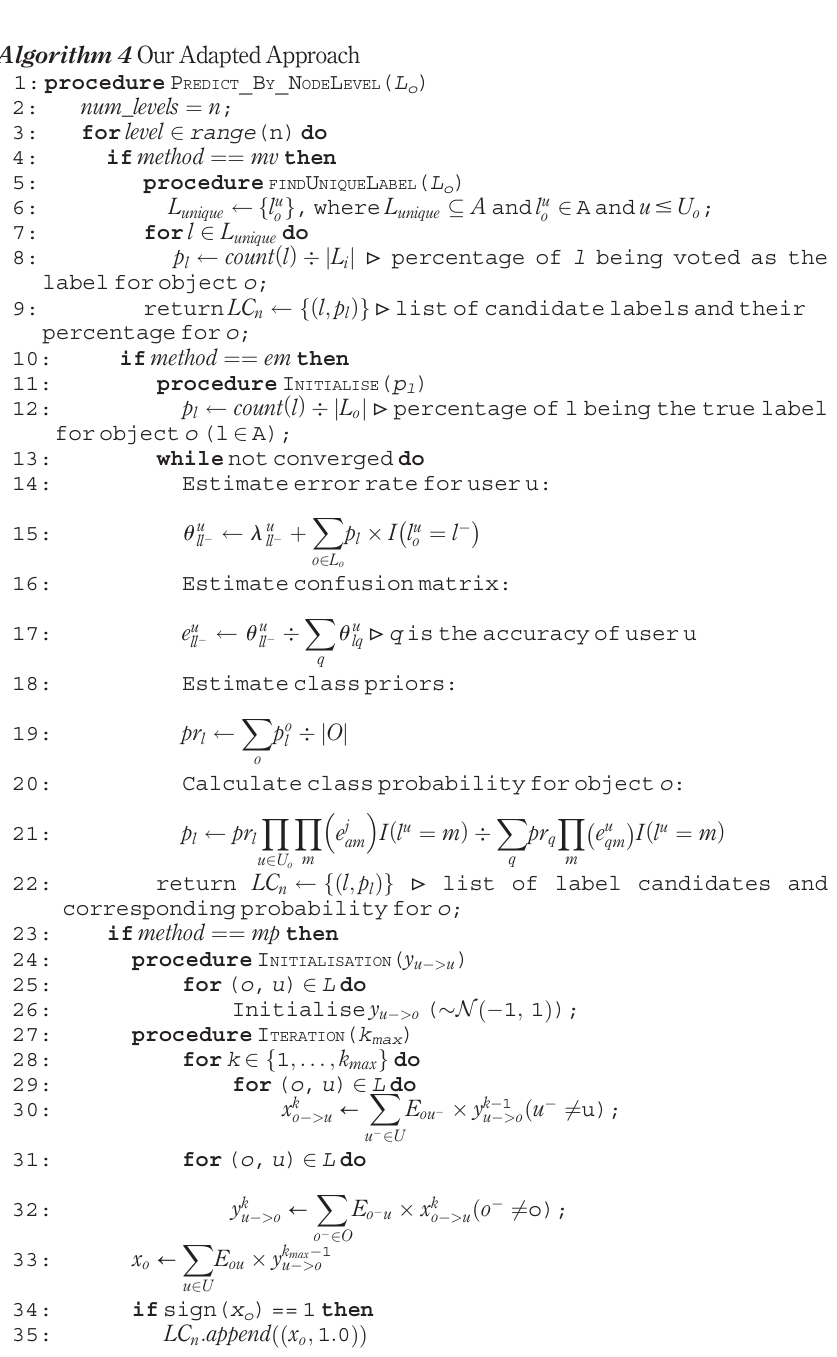
Algorithm 4 Our Adapted